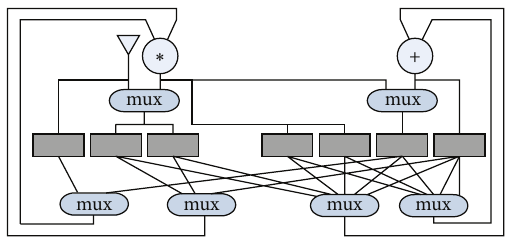
Figure 4: RTL structure of (1) from a PLF schedule S 1 . It has one port and uses minimum functional units.